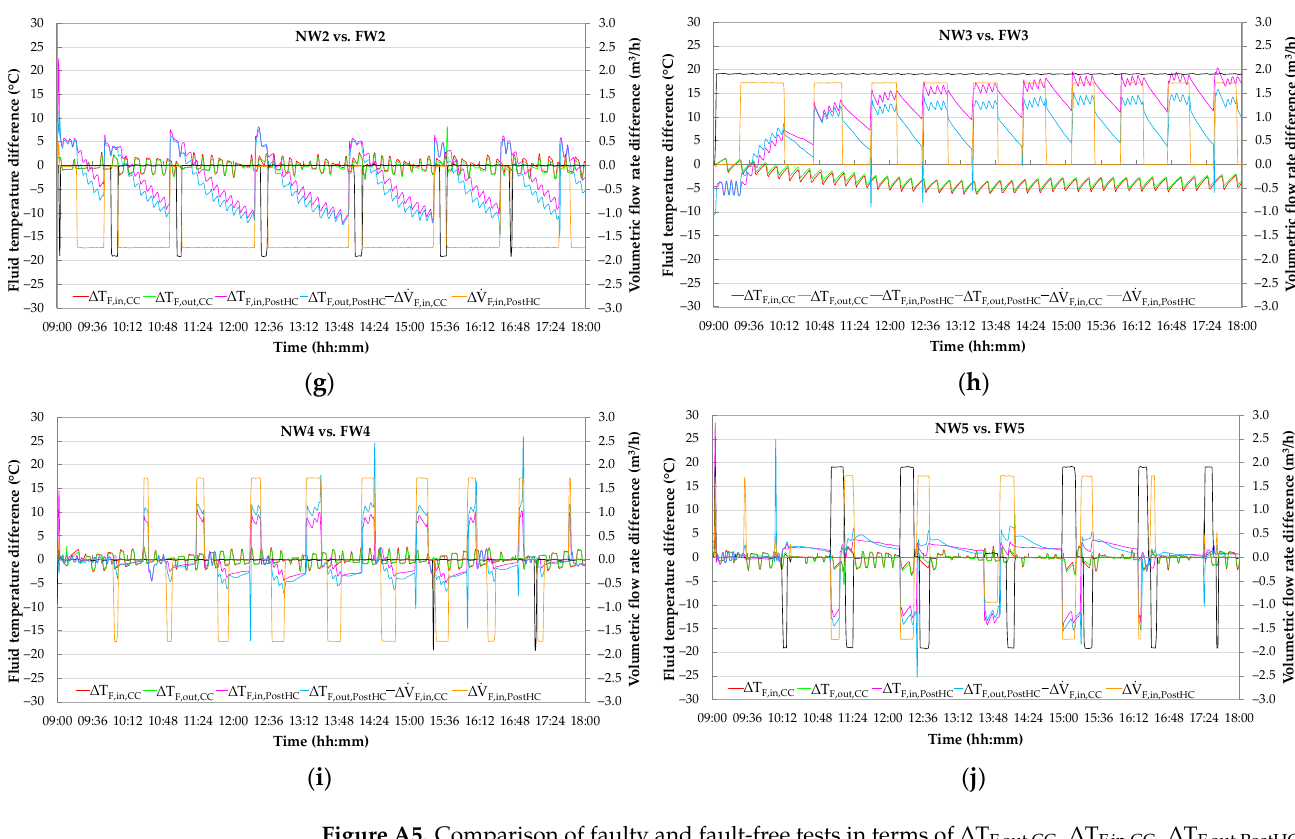
Figure A5. Comparison of faulty and fault-free tests in terms of ∆ T F,out,CC , ∆ T F,in,CC , ∆ T F,out,PostHC , ∆ T F,in,PostHC , V F,in,CC and ∆ V F,in,PostHC (Equations (A11)–(A16)): comparison between NS1 and FS1 ( a ), NS2 and FS2 ( b ), NS2 and FS3 ( c ), NS1 and FS4 ( d ), NS3 and FS5 ( e ), NW1 and FW1 ( f ), NW2 and FW2 ( g ), NW3 and FW3 ( h ), NW4 and FW4 ( i ), NW5 and FW5 ( j ).